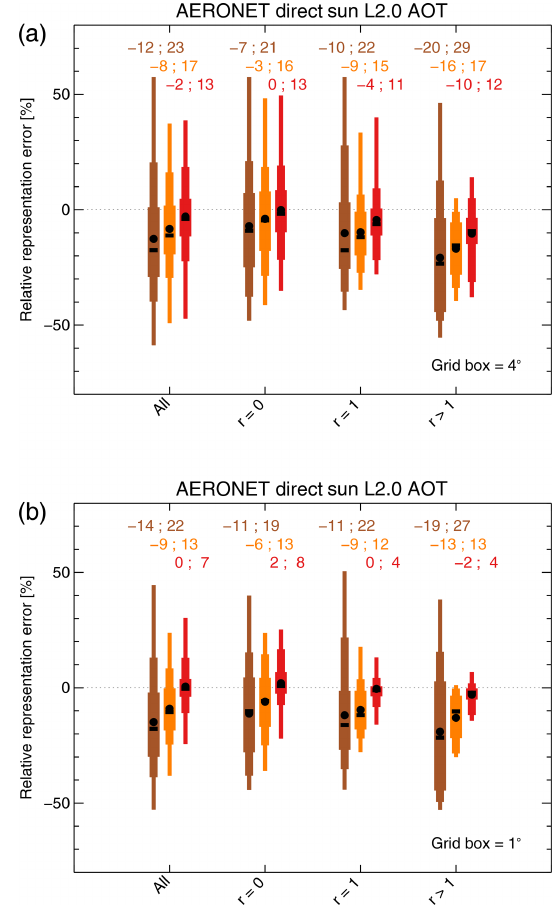
Figure 9. Yearly representation errors for AOT from AERONET direct sun L2.0 for different range scores r by Kinne et al. (2013), for a model grid-box size of either 4 ◦ or 1 ◦ . The colours indicate different collocation protocols: yearly (brown), daily (orange) and hourly (red). Numbers on top are the means of the errors and means of the signless